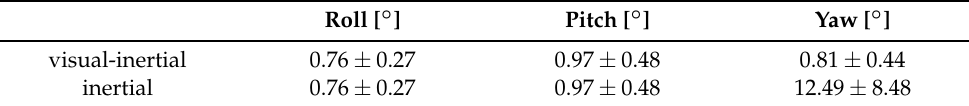
Table 1. Mean of RMSE values for inertial and the proposed visual-inertial orientation estimation [Mean standard ±